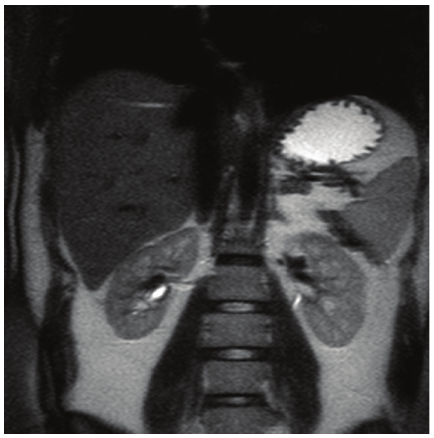
Figure 2: Intraoperative view of the AML.